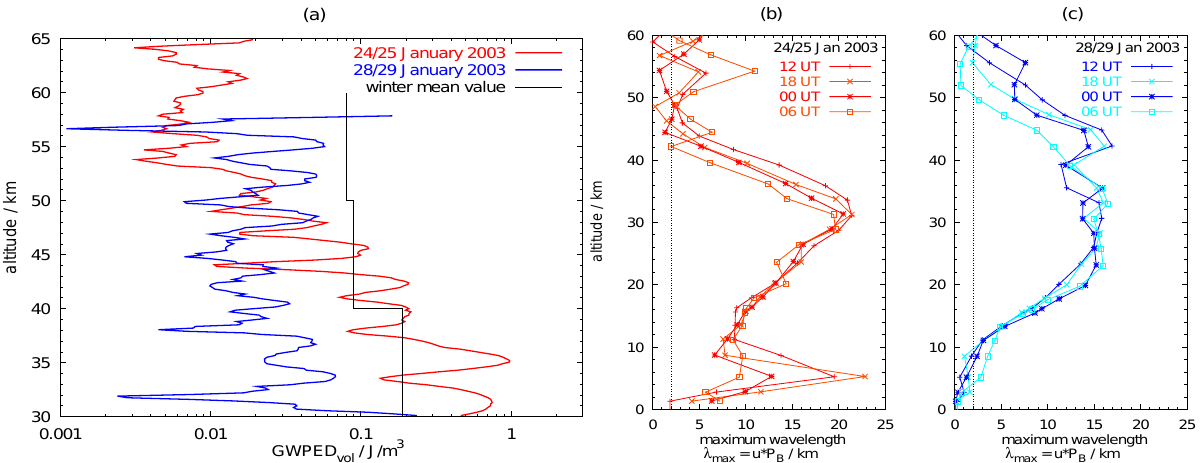
Fig. 5. The left plot (a) shows the gravity wave potential energy density profiles measured at Esrange for 24/25 January (red line) and 28/29 January (blue line). Additionally shown is the winter mean value of the GWPED vol for different altitude region (black line). The two subfigures (b) and (c) show the maximum vertical wavelength λ max that can penetrate through the atmosphere for pure zonally penetrating stationary gravity waves on 24/25 January (b) and 28/29 January 2003 (c). Vertical lines at λ max = 2km wavelength mark the minimum vertical wavelength observable by the lidar